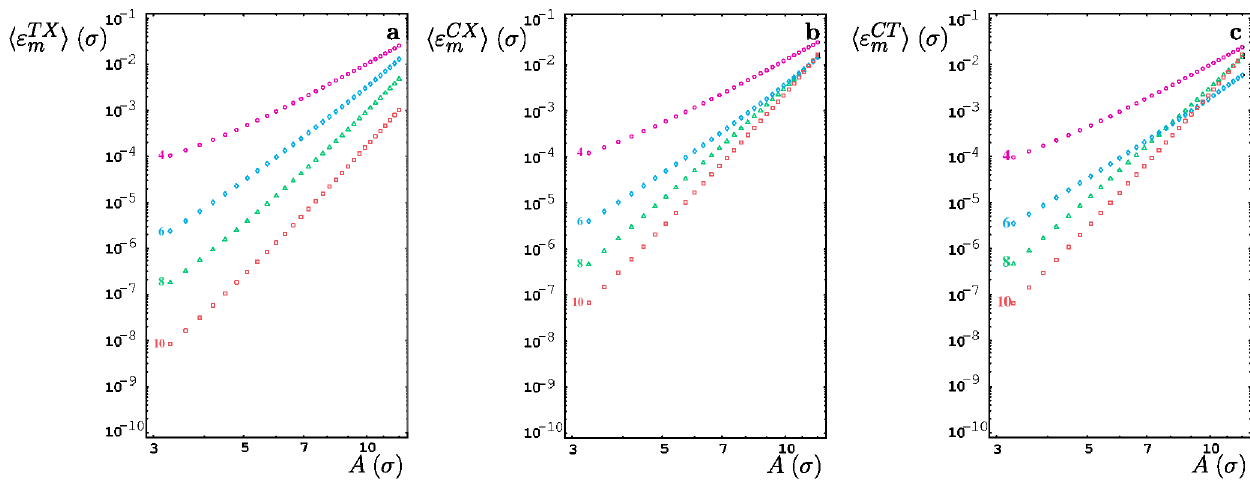
i versus amplitude, parametrized by map order m (indicated by 10, 8, 6, and 4 in the FIG. 7. (Color) Average one-turn error h " (cid:27) m figure), for a comparatively large relative momentum deviation of (cid:29) (cid:1) 7 : 5 (cid:5) 10 (cid:6) 4 . The different plots show results averaged over an orbit of 1000 turns for the one-turn error between (a) direct and Taylor map tracking, TX , (b) direct and Cremona map tracking, CX , and (c) Taylor map and Cremona map tracking, CT